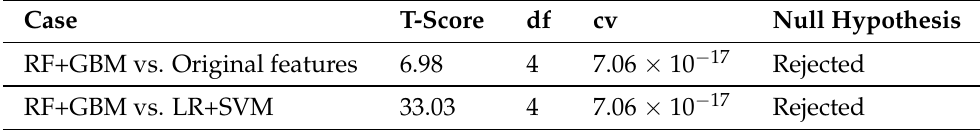
Table 17. Statistical T-test results.